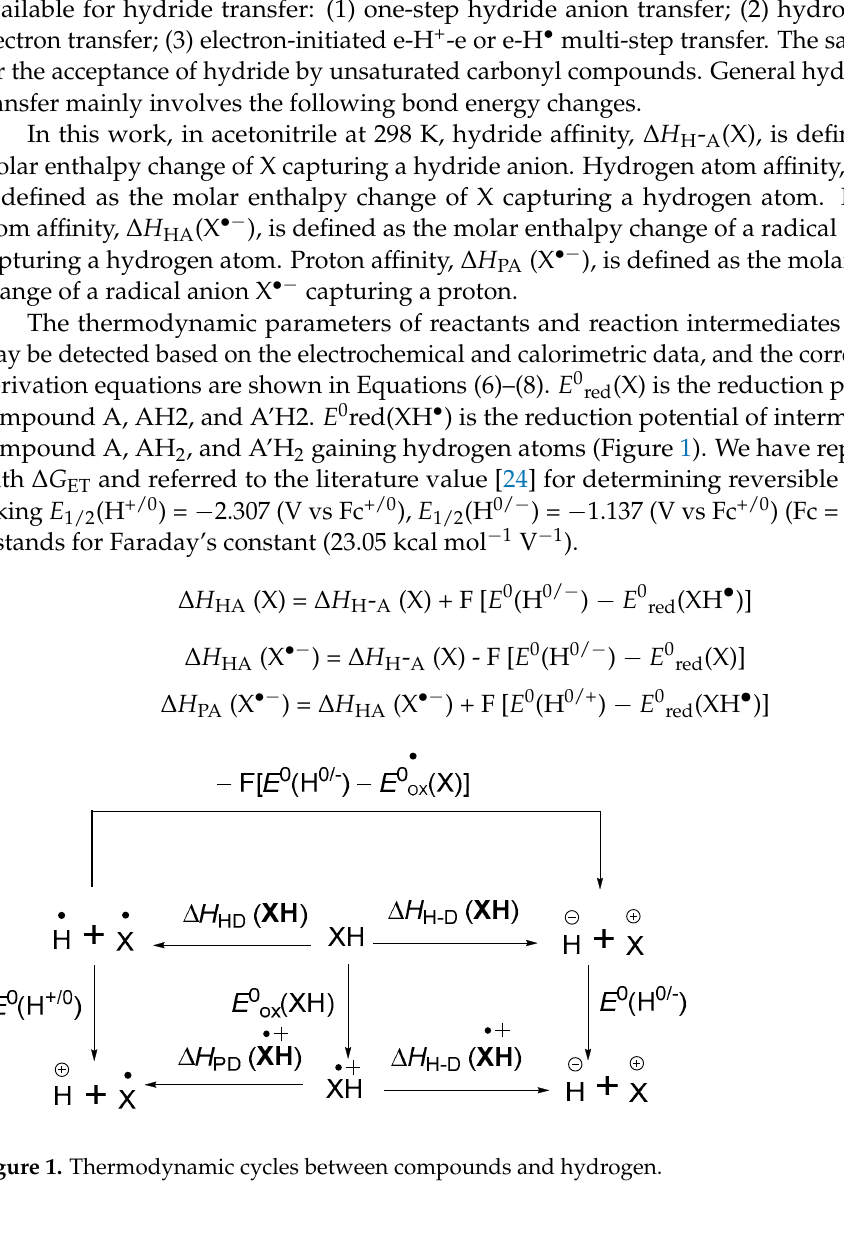
Figure 1. Thermodynamic cycles between compounds and hydrogen. 2. Results Common electrochemical measurement method mainly includes cyclic voltamme- try (CV) and Osteryoung square wave voltammetry (OSWV). In this study, we have used these methods to determine the single-electron reduction potentials of three types of un-